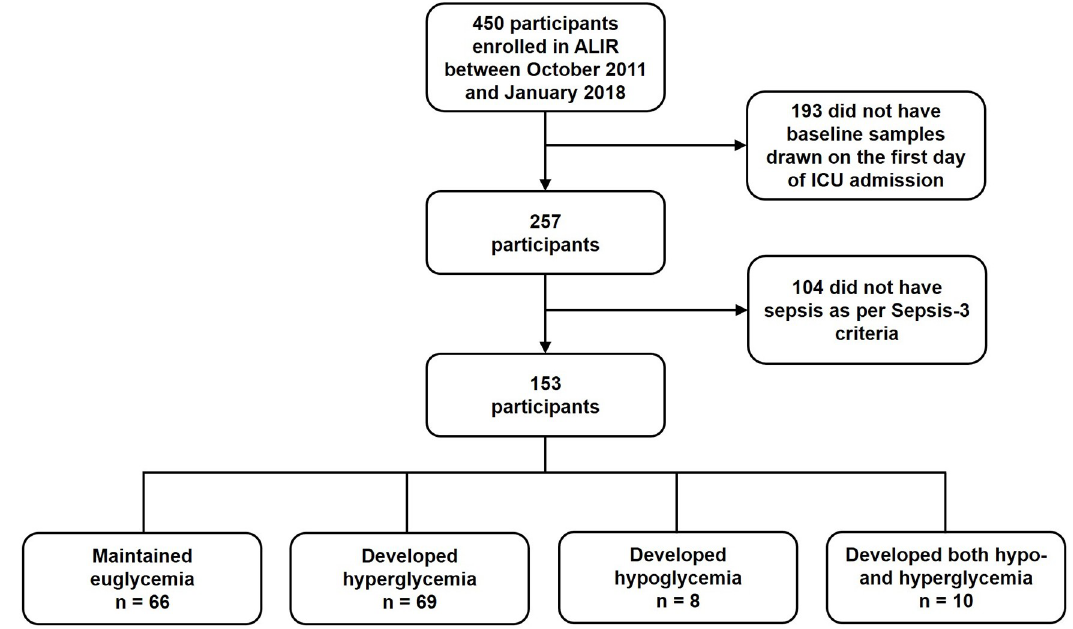
Fig 1. Diagram of participants included in